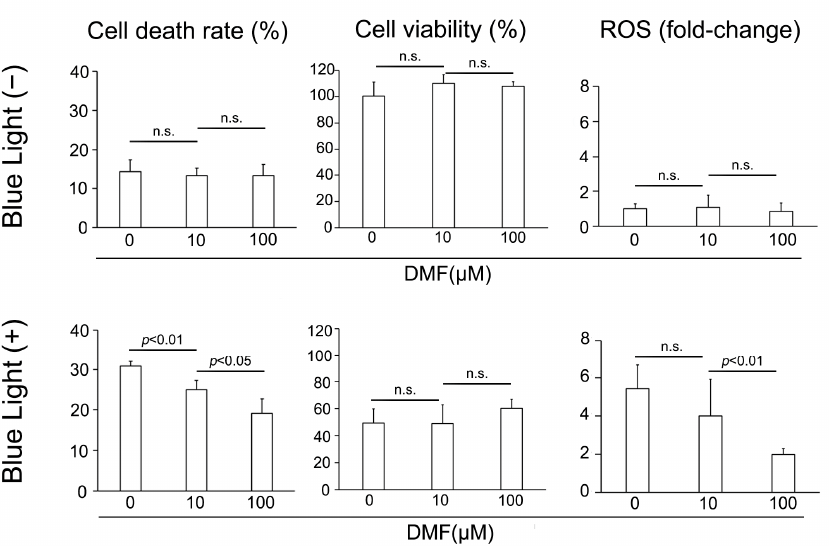
Figure 2. Change in cell death rate, cell viability, and ROS generation after blue-light (BL) exposure and with DMF. BL exposure increased ARPE-19 cell death (LDH release), which DMF decreased it dose-dependent manner ( n = 4 per group). BL exposure and DMF treatment did not change ARPE-19 cell viability ( n = 4 per group). BL exposure induced ROS generation in ARPE-19 cells, which DMF alleviated in a dose-dependent manner ( n = 6 per group). Statistical analysis was performed using one- way ANOVA, followed by Tukey’s multiple comparisons test where appropriate. DMF = dimethyl fumarate, ROS = reactive oxygen species, n.s. = not